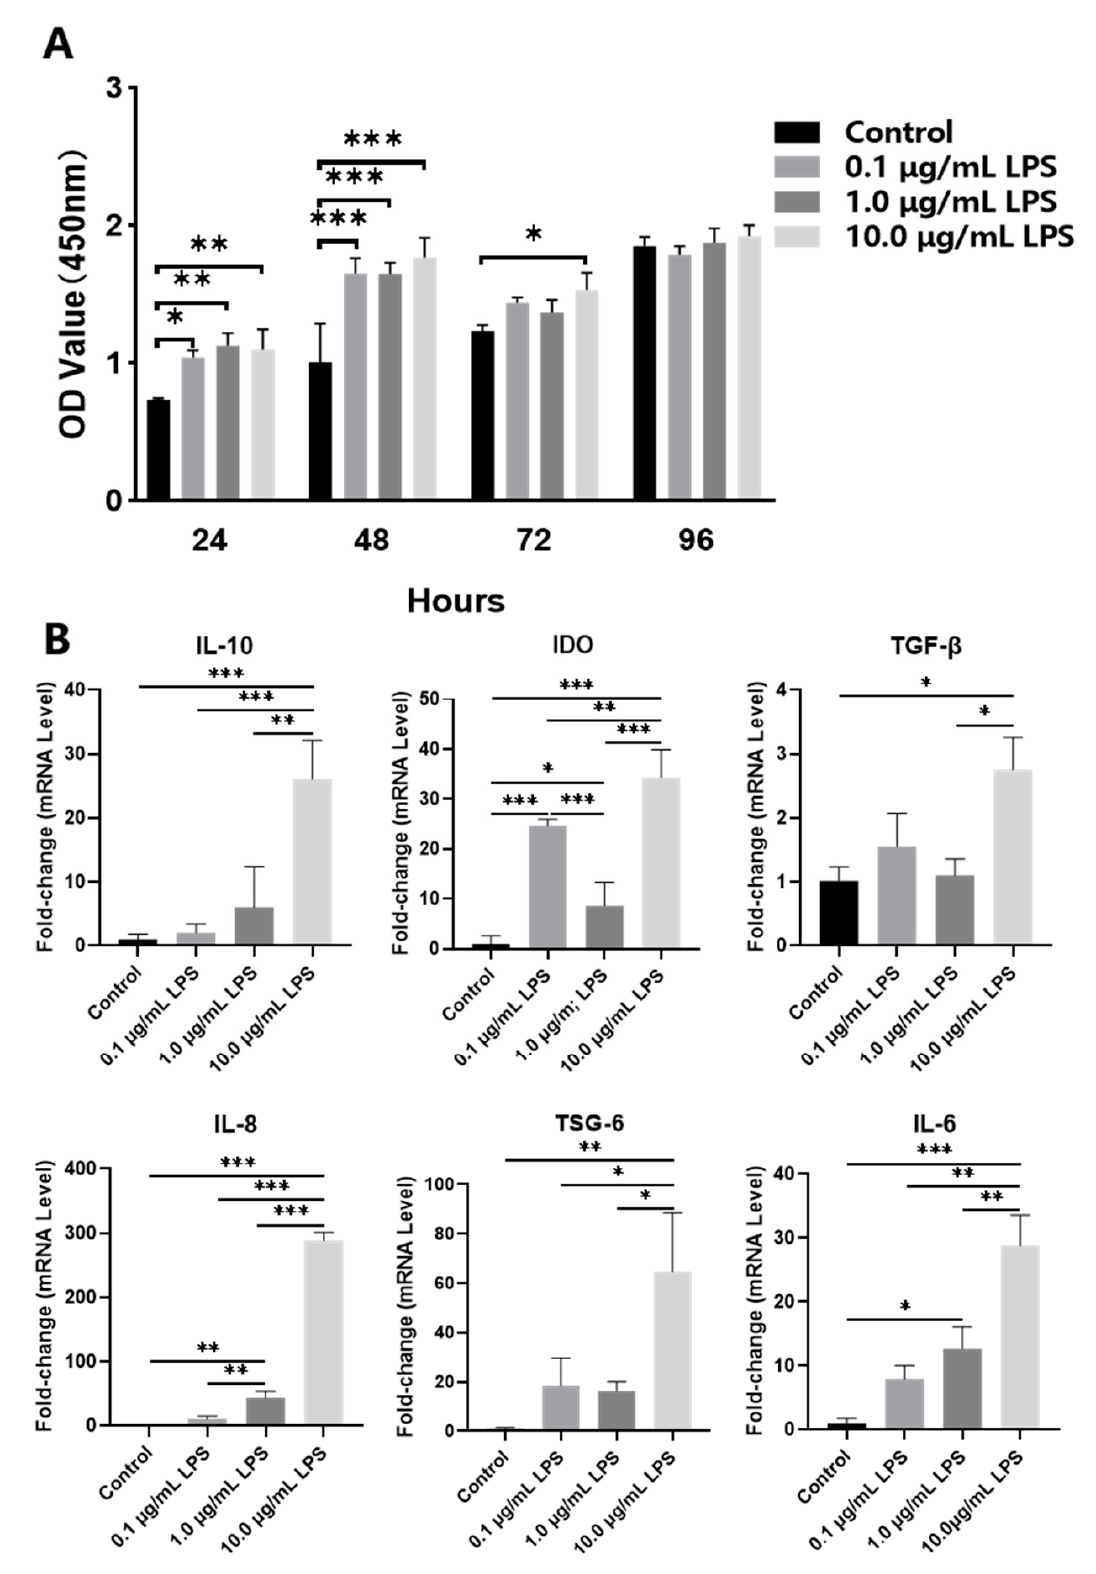
Figure 2. Effect of LPS pretreatment on PDLSCs. ( A ) CCK8: PDLSC proliferation after culturing with 0 (Control), 0.1, 1.0 and 10.0 µg/mL LPS for 24, 48, 72 and 96 h. ( B ) qRT-PCR: IL-10 , IDO , TSG-6 , IL-6 , IL-8 and TGF- β mRNA expression in PDLSCs after culturing with 0 (Control), 0.1, 1.0 and 10.0 µg/mL LPS for 48 h. * p < 0.05; ** p < 0.01; *** p < 0.001.